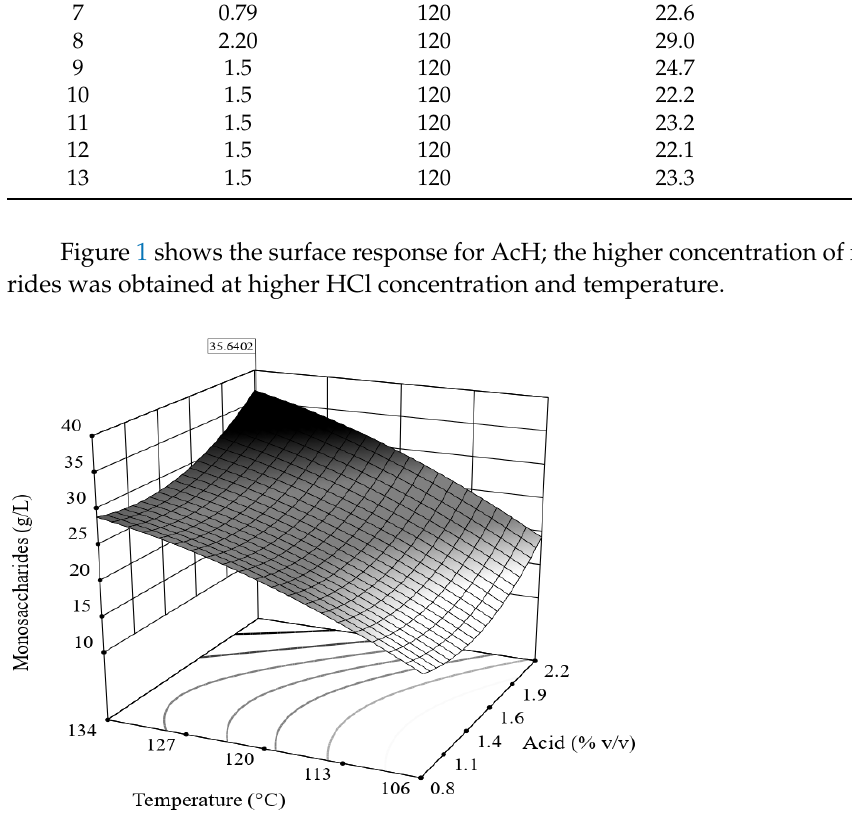
Figure 1. Surface response plot for acid hydrolysis of bored coffee beans. According to the quadratic polynomial model (Equation (8), R 2 = 0.948 and fitted R 2 = 0.912), the concentration of sugars can be maximized up to 35 g/L at 134 °C and 2.2% HCl.